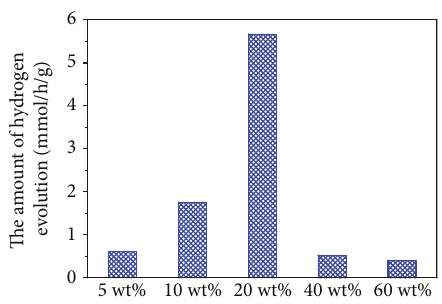
production activity of the samples. 2